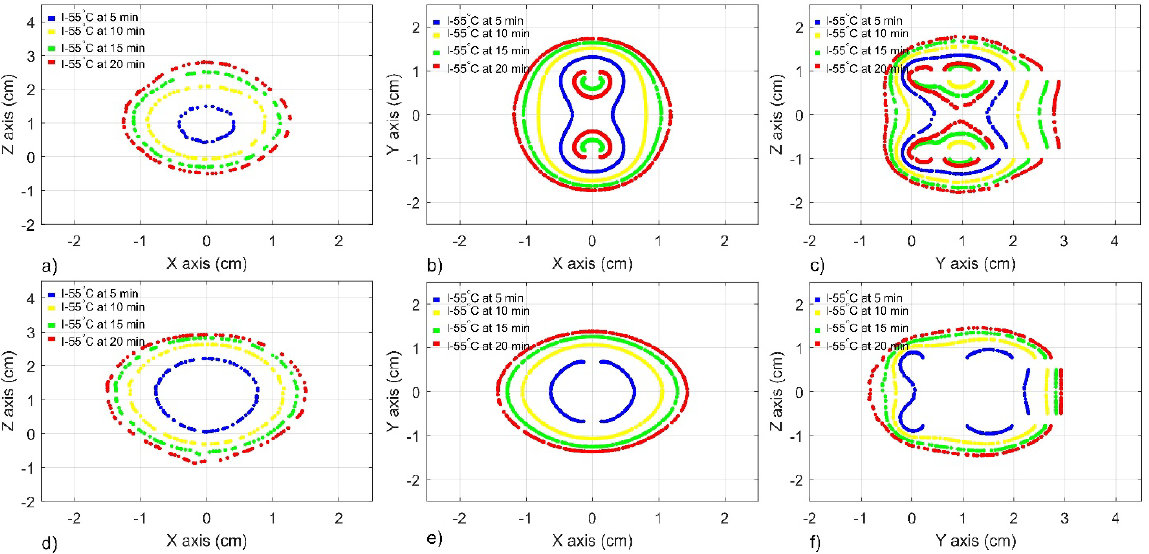
Figure 7. Isotherm contour at 55 ◦ C generated by a linear antenna array over different planes after 5 min, 10 min, 15 min, and 20 min of treatment time. ( a – c ) XZ, XY, and YZ planes for a DS antenna array with ad = 15 mm and bt = 30 mm, respectively ( d – f ) XZ, XY, and YZ planes for a MTM antenna array with ad = 10 mm and bt = 40 mm,